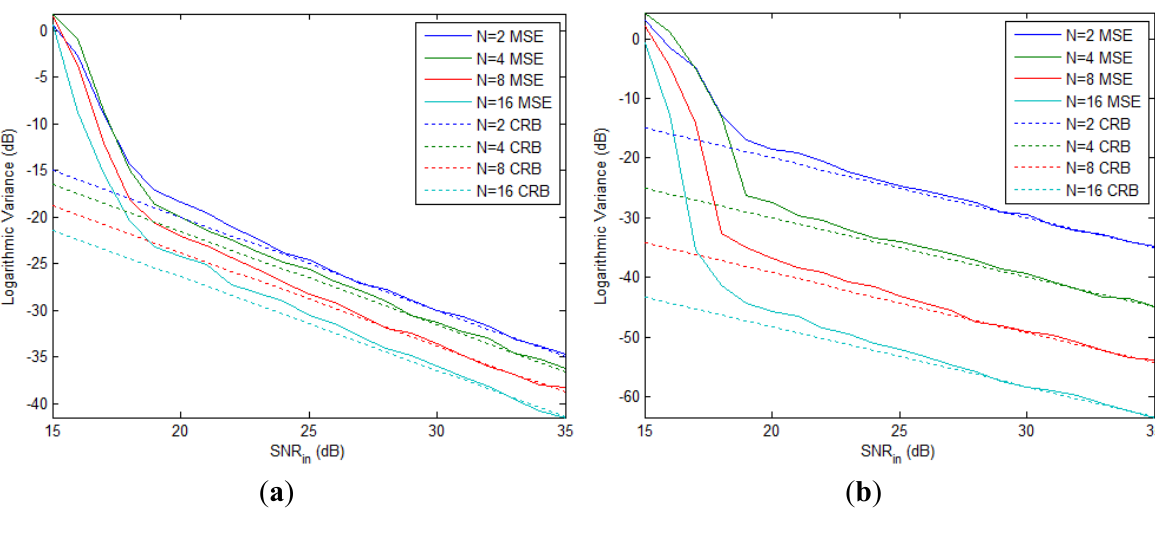
Figure 3. The logarithmic MSE and CRB of ( a ) the total phase difference and ( b ) the Doppler frequency vs. input SNR.